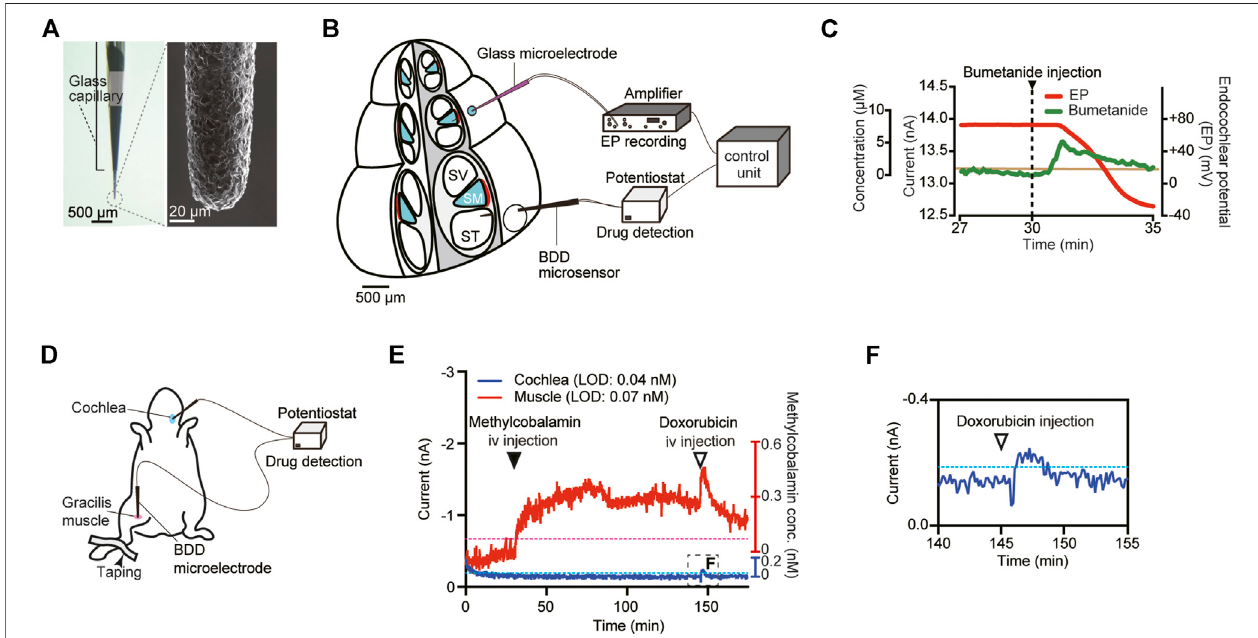
FIGURE 4 | In vivo electrochemical drug monitoring with a boron-doped diamond (BDD) electrode. (A) A needle-type BDD microelectrode. As shown in the left panel,theBDDneedlewasencasedwithaglasscapillarytube. Theneedletip,whichhasadiameterof ∼ 40 μ m,waspulledoutofthecapillary.Therightpaneldisplaysa magni fi ed image of the tip obtained by means of a scanning electron microscope. (B) The experimental setup for in vivo detection of bumetanide in a cochlea. A BDD microelectrode was inserted into the perilymph of the scala tympani (ST), whereas a glass microelectrode for recording of the endocochlear potential (EP) was placedin the endolymph ofthescala media (SM). SV: scalavestibuli. (C) In vivo recordingofbumetanidelevels in the cochlea. Bumetanidewasinjected intothe external jugular vein 30 min (arrowhead) after the onsetofthe measurement. The green linedenotes thecurrentdetectedby theBDD microelectrode, whereas theEP measured with the glass microelectrode is displayed by the red line. The concentration scale on the vertical axis was calculated on the basis of in vitro calibration of the BDD electrode(fordetails, see Ogataet al.,2017).Thebrownlinemeansthe invivo limitofdetection forthemicroelectrode.Adapted from Ogataet al.(2017) withpermission from Springer Nature. Copyright (2017) Nature Biomedical Engineering. (D) Schematic illustration of the in vivo experimental setup for methylcobalamin detection in a guinea pig. The system contains two different BDD microsensors: one was inserted into cochlear perilymph, and the other was placed in the extracellular space of the gracilis muscle of the right hind leg. (E,F) In vivo recording of methylcobalamin concentrations. The currents in perilymph (blue) and in the muscle (red) were simultaneously measured with two BDD microelectrodes. The concentration scales on the vertical axis are derived from in vitro calibration for each electrode (for details, see Hanawa et al., 2020). Methylcobalamin (10 mg/kg) was injected into the left external jugular vein at 30 min ( fi lled arrowhead) after the onset of the recording. Then, doxorubicin(5 mg/kg)wasinjectedviathesameroute(openarrowhead).Thetraceintheboxedregionin (E) isenlargedinpanel (F) .Thelimitofdetection(LOD)foreach microsensor is indicated as a blue (muscle) or red (cochlea) dotted line. Adapted from Hanawa et al. (2020) with permission. Copyright (2020) American Chemical